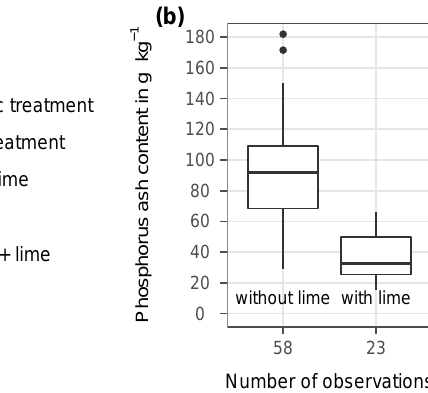
Figure 5. Comparison of measured sludge P concentrations from sludge monitoring data to theoreti- cal sludge P concentrations derived from WWTP-sewage P-inflow minus P-outflow.